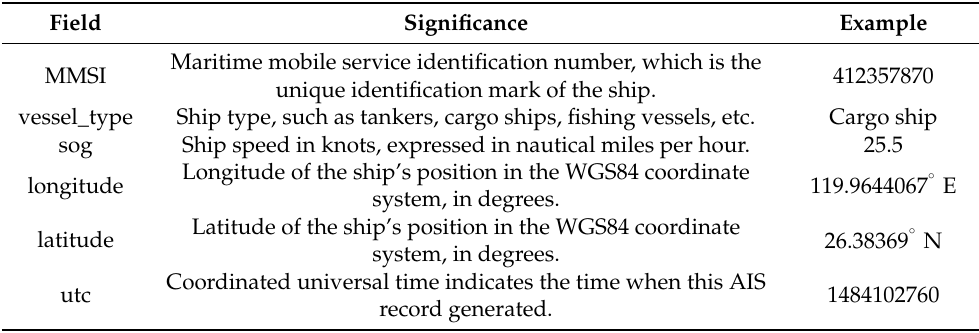
Table 1. Key attributes of AIS data used in this